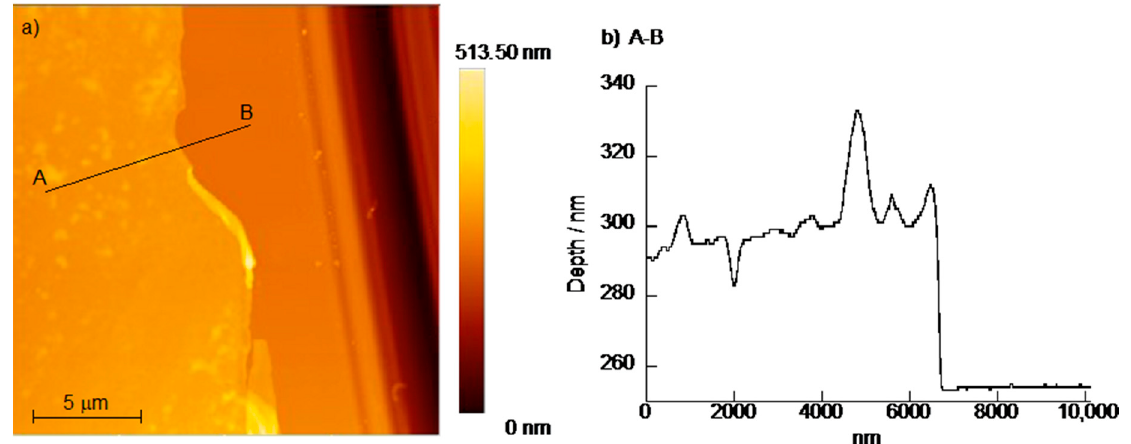
Figure 6. ( a ) atomic force microscopy (AFM) image and ( b ) depth profile of (PBA-PAMAM/PVA) 5 film.